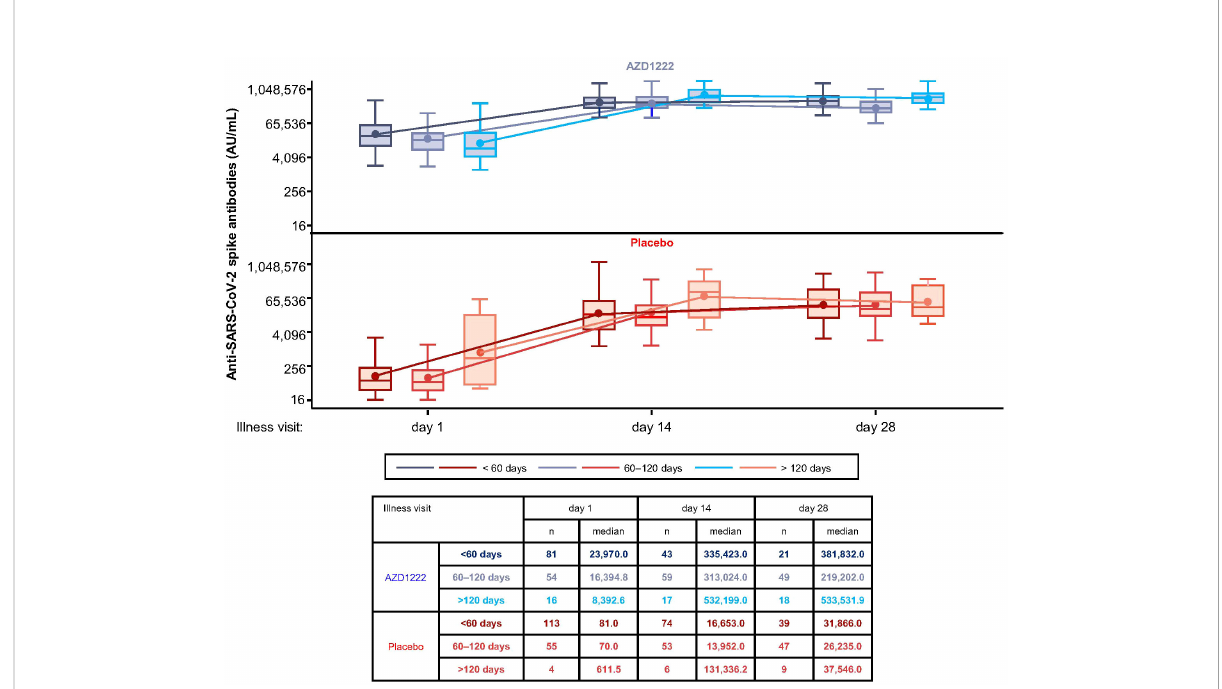
FIGURE 4 Initial breakthrough SARS-CoV-2 spike-binding antibody titers are in fl uenced by the interval since second dose primary series vaccination. Levels of anti-SARS-CoV-2 spike-binding antibodies by time since second dose of primary series vaccination. The bottom and top edges of the box indicate the fi rst and third quartiles, the difference is the IQR, the line inside the box is the median, and the marker inside the box is the mean. The whiskers that extend from the box indicate the minimum and maximum after removing outliers (i.e., datapoints >1.5 x IQR from the